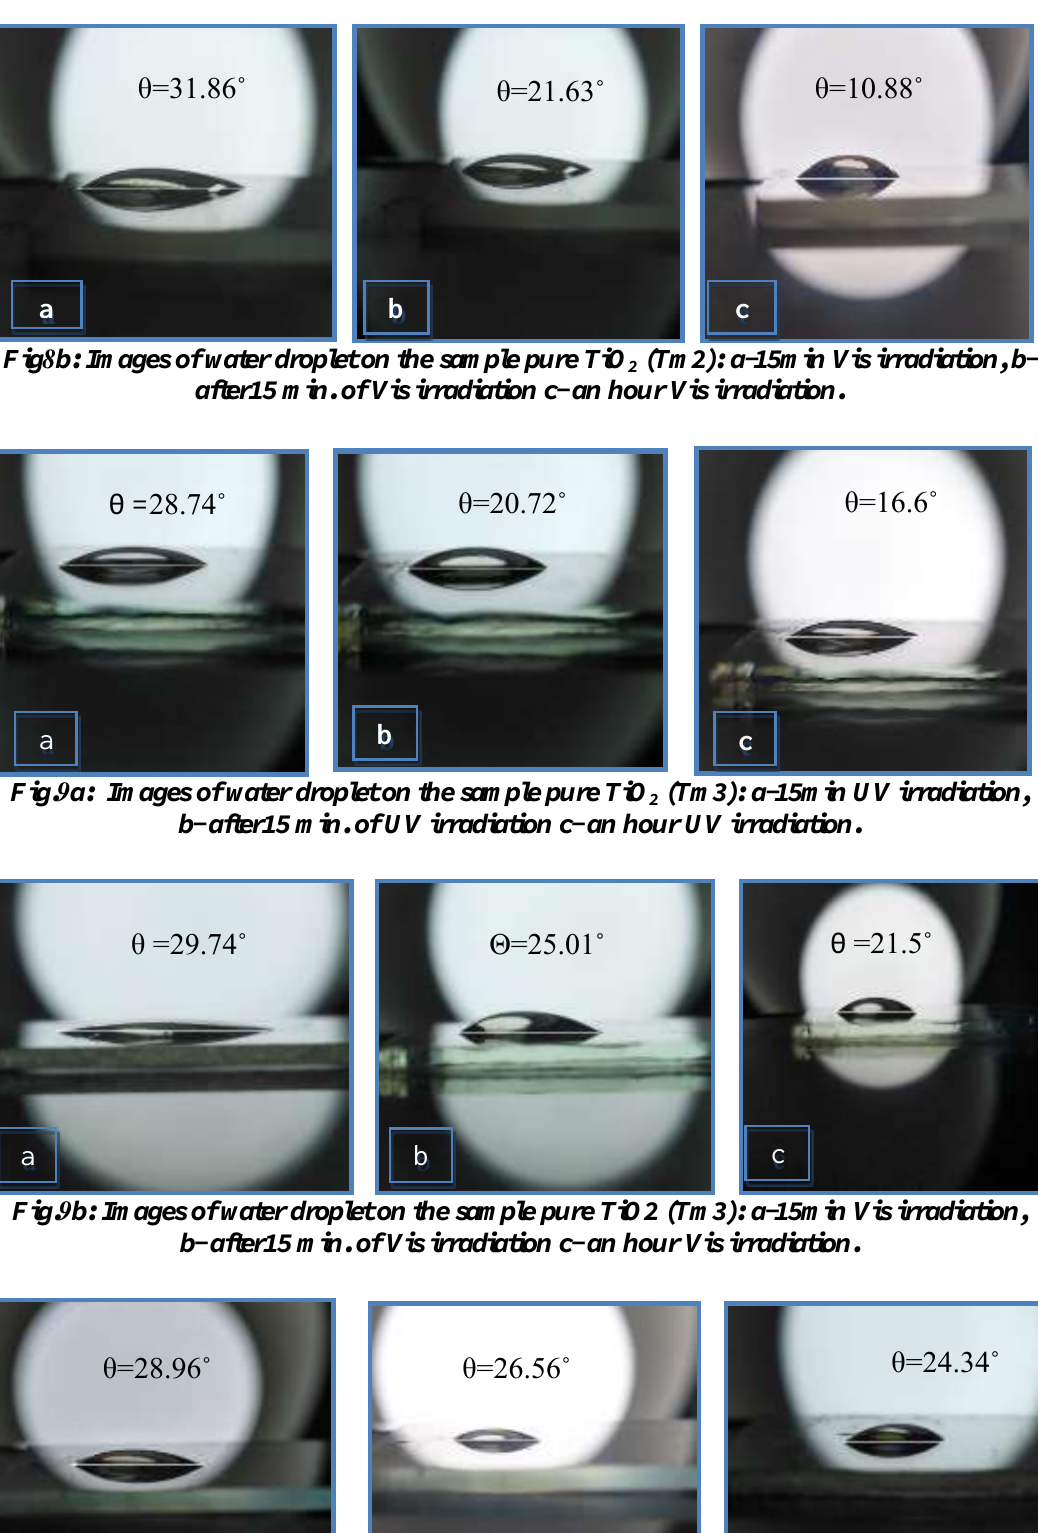
(Tm4): a-15min UV irradiation, 2